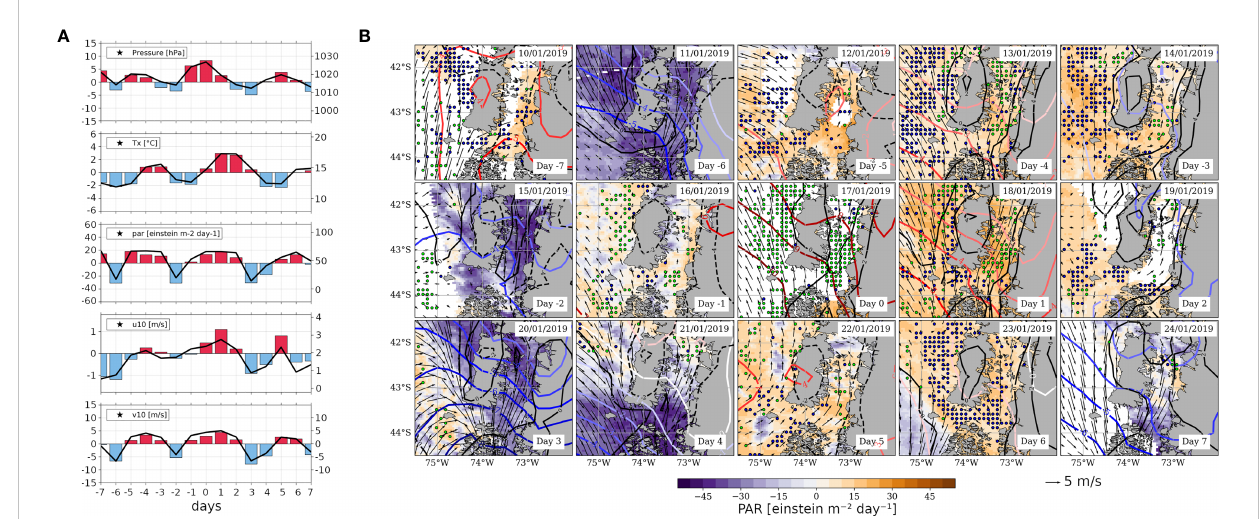
FIGURE 7 As Figure 4, but referred to the case study around the HBE of January 17, 2019 (day 0). (A) Time series calculated as fi eld averages within the S-ISC subregion (42.5°-43.5° S; see Figures 1A) for a sequence of days centred on the HBE onset, i.e., on day 0, spanning from day -7 to day +7. Variables correspond to MSLP [hPa], Tx [°C], PAR [einstein m -2 day -1 ], and U and V components of wind at 10m [m s -1 ]. The right-hand y-axis of each panel shows the absolute values on solid black lines centred around the mean DJF value (central horizontal line), while the left y-axis shows the positive (negative) SY-IS anomalies on red (blue) bars centred around 0. (B) Maps centred on day 0, spanning from day -7 to day +7, showing PAR ’ (shaded, see colour scale), MSLP ’ (reddish contours every 1 hPa), Tx ’ (black contours every 2°C), 10m wind (black vectors, reference vector below the fi gure), and nFLH ’ (green [blue] dots depict gridpoints with nFLH ’ >0.1 [nFLH ’ <-0.1] W m -2 µm -1 sr -1